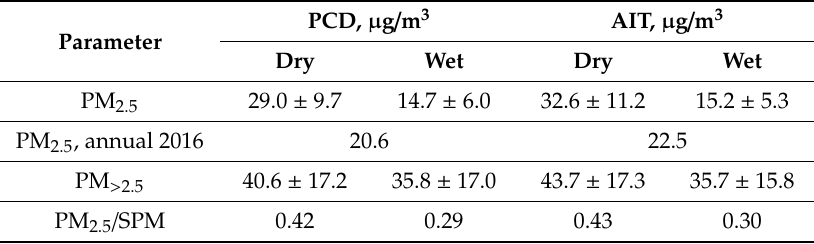
Table 1. Seasonal variation of PM 2.5 and coarse particles (PM >2.5 ) based on the entire sampling period (October 2015–February 2017). Source: Tanatat, 2018 (see text).